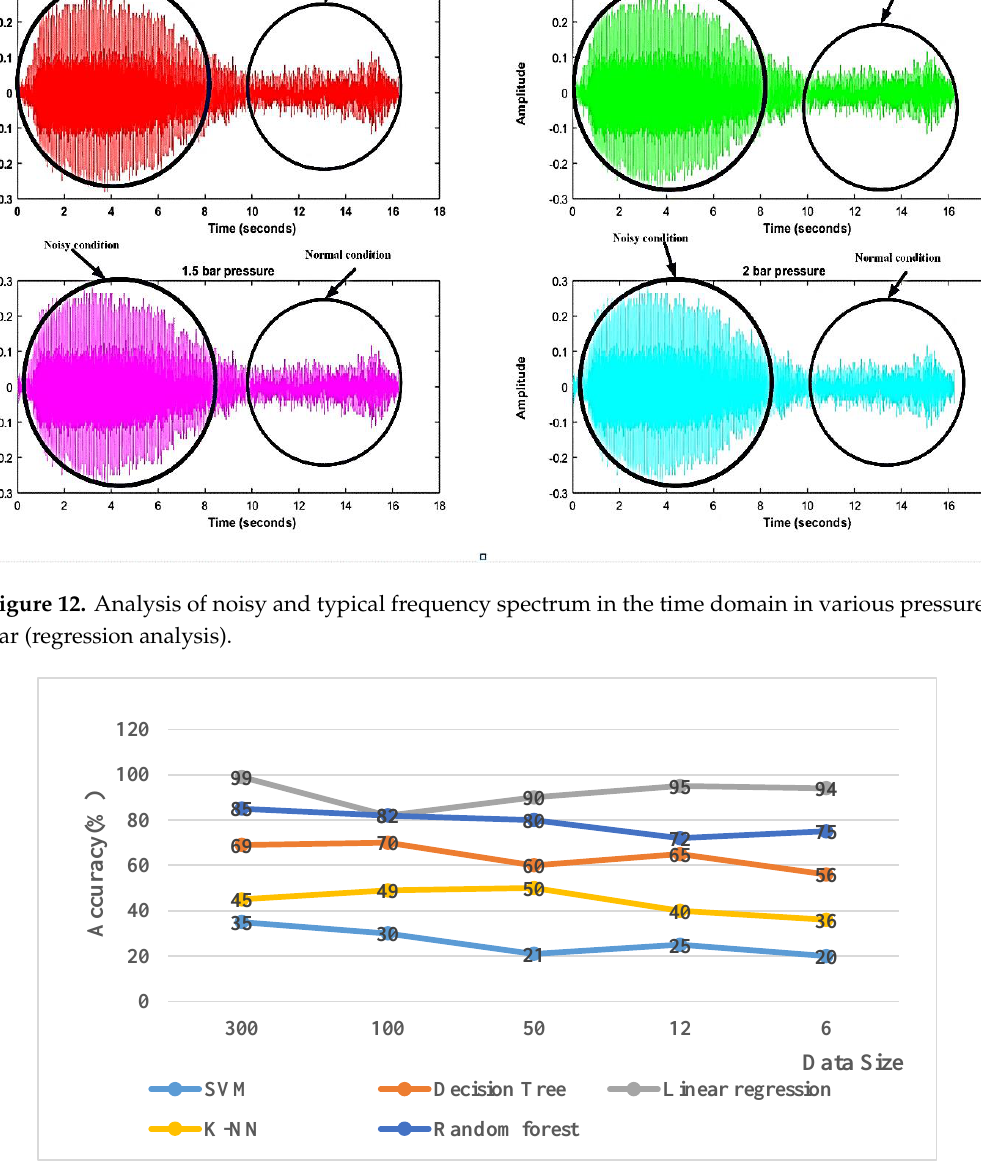
Figure 13. Comparisons among ML-based classification algorithms with data size .